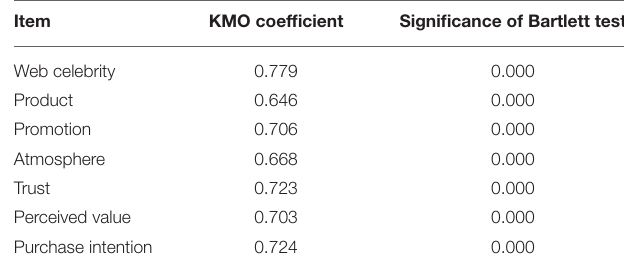
TABLE 2 | Reliability analysis of pilot test. TABLE 3 | KMO and Bartlett’s